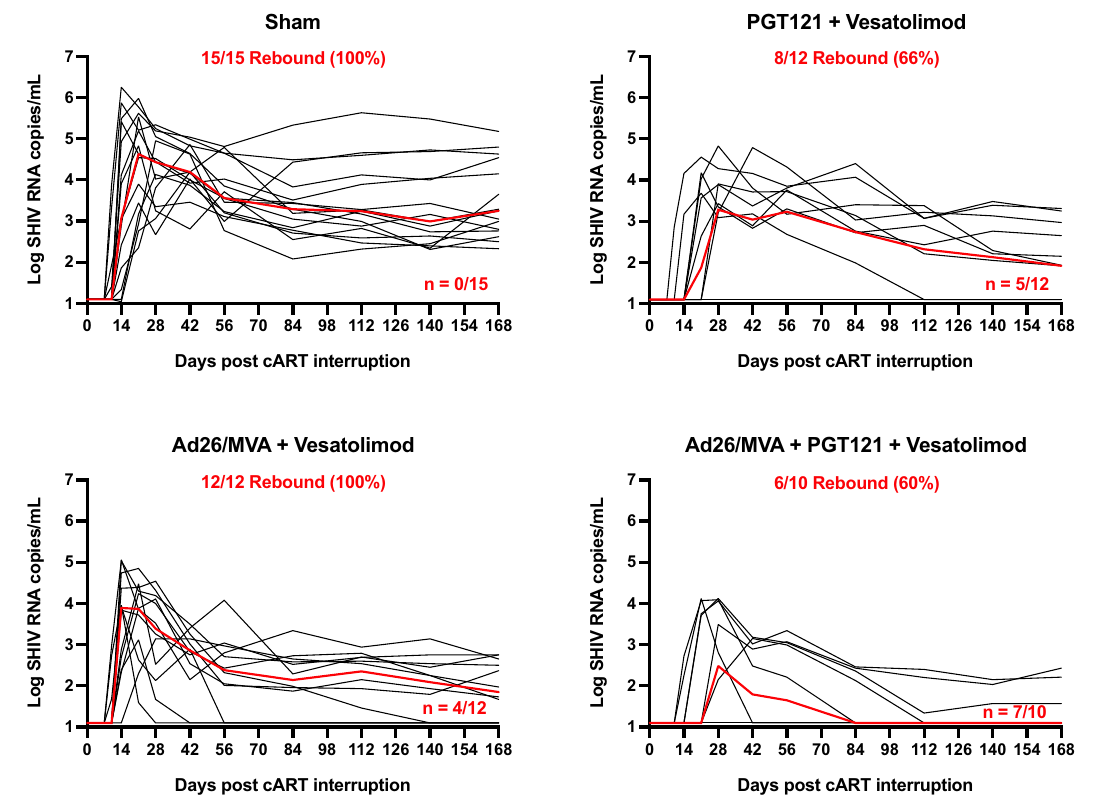
Fig. 3 The combination of vesatolimod, Ad26/MVA, and PGT121 treatment resulted in the fewest viremic animals post-ART cessation. Plasma SHIV viral loads from the cessation of ART to day 168 with the median viral load of each group indicated by a red line. The number and percentage of animals in each group that rebounded are indicated below the group label, and the number of animals in the group with a negative viral load at the end of the surveillance period is indicated in the lower right corner of each